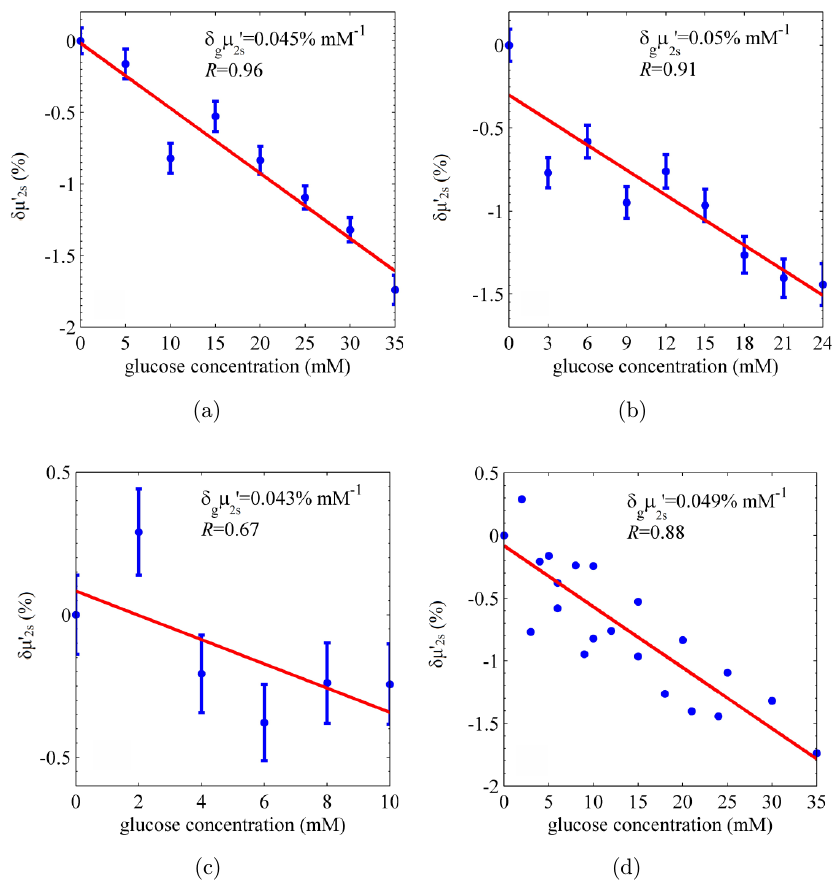
in 1% intralipid suspension via variation of glucose con- Fig. 2. The experimental results of the fractional changes (%) of (cid:1) 0 2 s centration. The increase per step of glucose measurements are (a) 5 mM in the concentration range of 0 – 35 mM, (b) 3 mM in the range of 0 – 24 mM, and (c) 2 mM in the range of 0 – 10 mM as shown in Figs. 2(a) – 2(c), respectively. The error bar represents the standard deviation of 10 measurements. Figure 2(d) shows all measurements presented in Figs. 2(a) –